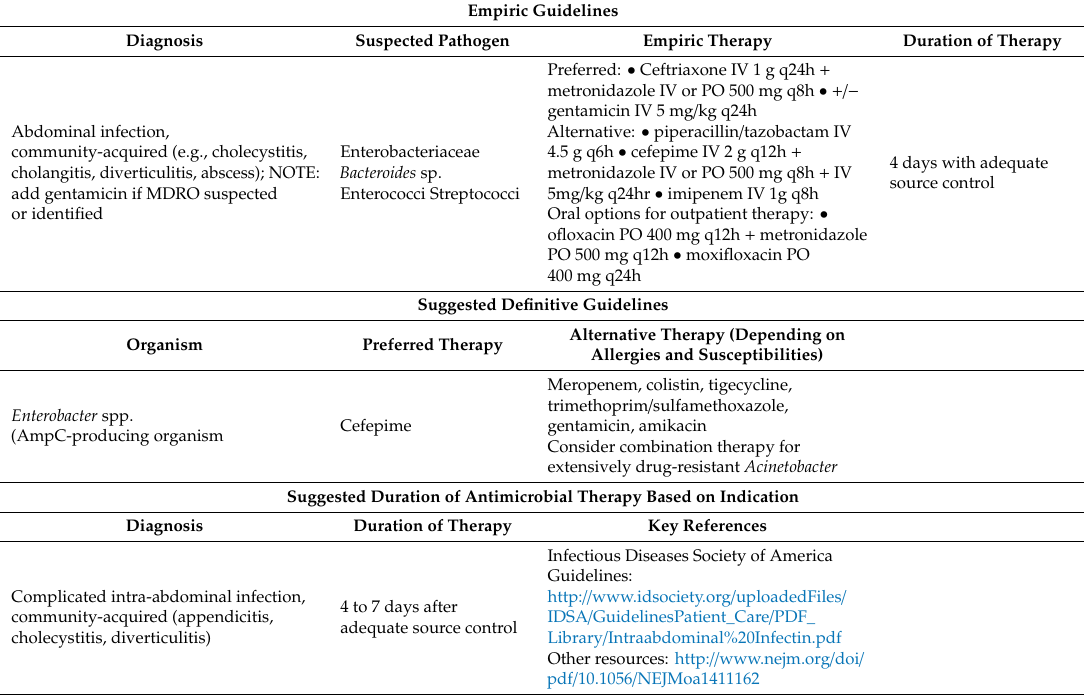
Table 4. Examples of empiric, definitive, and duration antibiotic prescribing